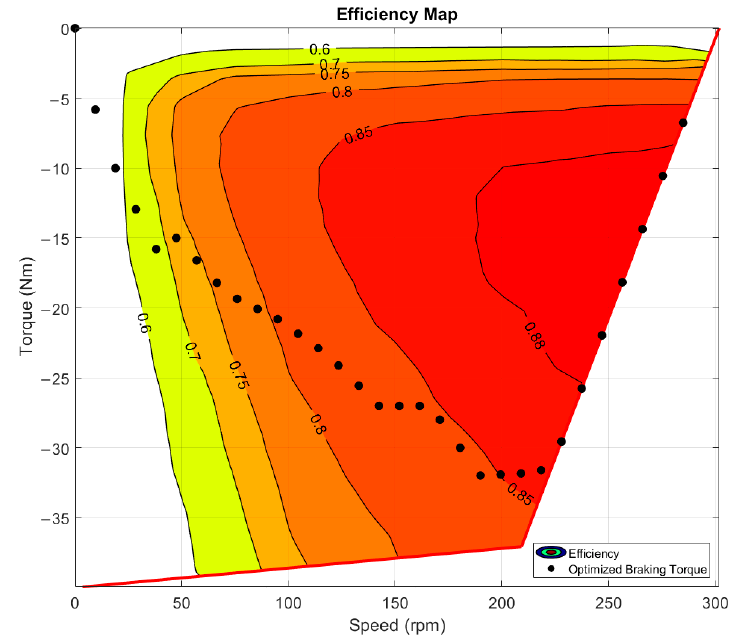
Figure 5. Optimized braking-torque on the efficiency map.